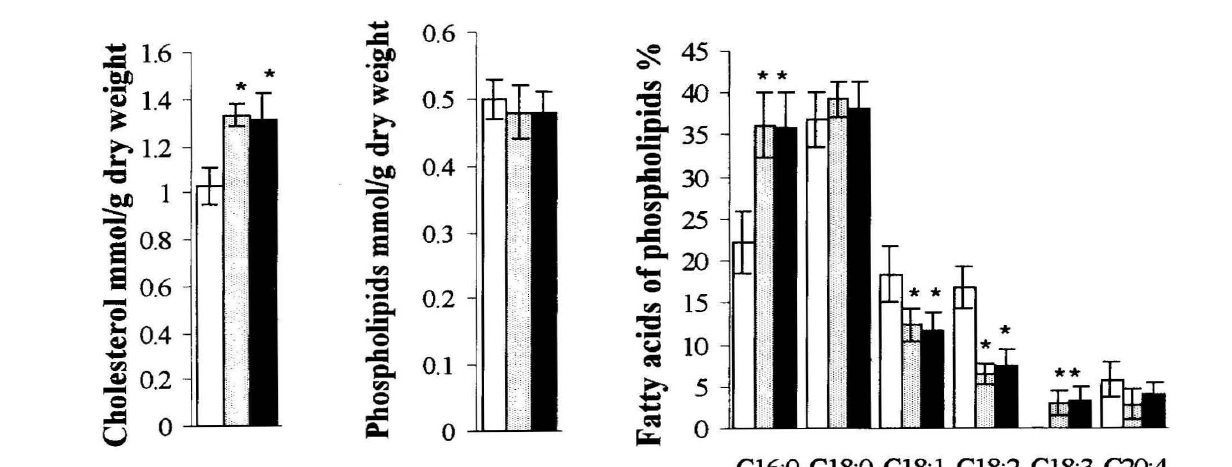
Figure 1. Concentration (mean ± S.D .) of cholesterol and phospholipids, as well as fatty acid content (in percent: mean ±S.D.) of phospholipids in controls (open bars) and in samples with 5 pmoljg wet weight (dotted bars) and 30 pmolj g wet weight (hatched bars) neopterin. Samples of rat liver tissue homogenates were used to test for phospholipid biosynthesis in vitro. Incubation medium: Krebs-Ringer-phosphate buffer, containing 0.3% albumin (pH=7.4), fatty acid mixture and glycerol. Samples were incubated twice for 4 h at 37"C . *The changes are statistically significant (p < 0.05- P <